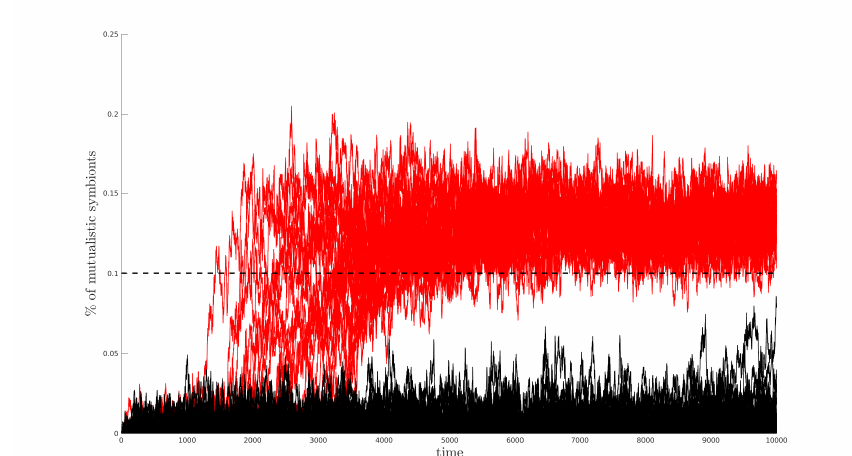
Figure SI.8. Evolution of the percentage of mutualistic symbionts in the population over 129 simulations. Red curves corresponds to replicates such that the percentage of mutualistic symbionts remains greater than the threshold of 10% – transition to mutualism. Black curves corresponds to replicates where the percentage remains below the 10% threshold – no transition.